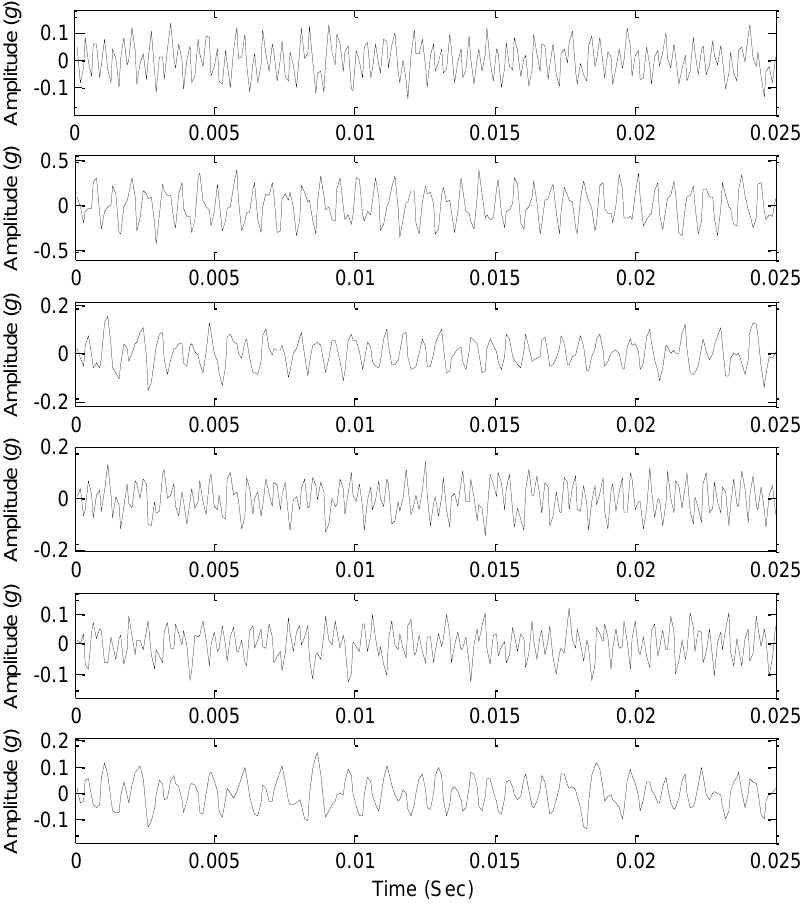
Figure 12. Waveforms of the mixed signals.